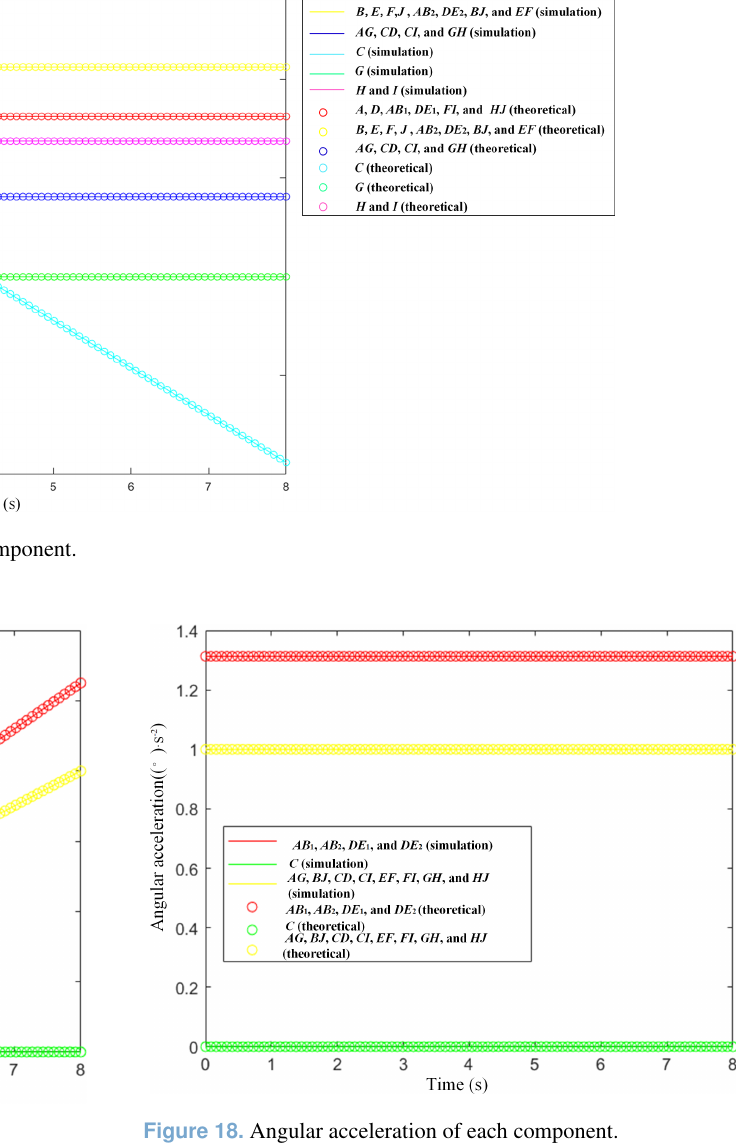
Figure 17. Angular velocity of each component.